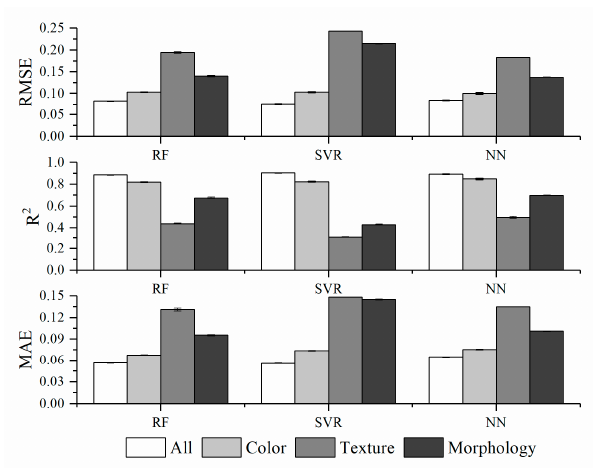
Figure 6. Capabilities of di ff erent image-based phenotyping methods in predicting the plant N status based on the evaluation of nitrogen nutrition index (NNI). The overall prediction accuracies of each type of phenotypic trait are included. The error bars represent the standard deviation. The white, light gray, gray, and dark gray bars indicate the prediction accuracies obtained using all traits, color-, texture-, and morphology-related traits, respectively.